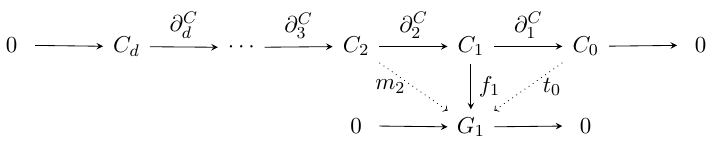
Figure 5 . We obtain the chain complexes that de(cid:12)ne Abelian 1-gauge theories in d dimensions by setting G 0 = G 2 = 0 in example 2.1. The relevant maps are the con(cid:12)gurations associated to the links f 1 , the gauge transformations t 0 , and the 1-holonomies m 2 , as explained in 4. where H ( C ) is the homology group of order n with integer coe(cid:14)cientes of the n